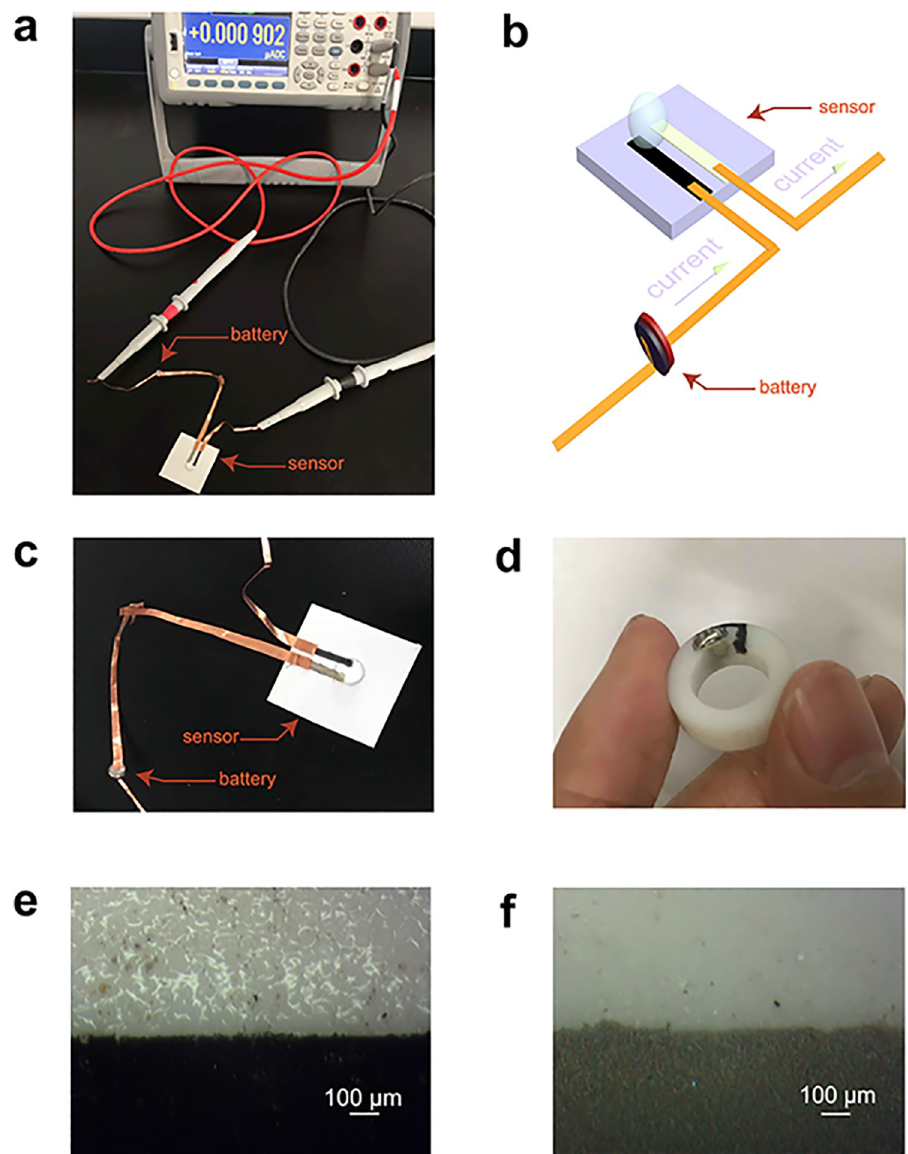
electrode on the